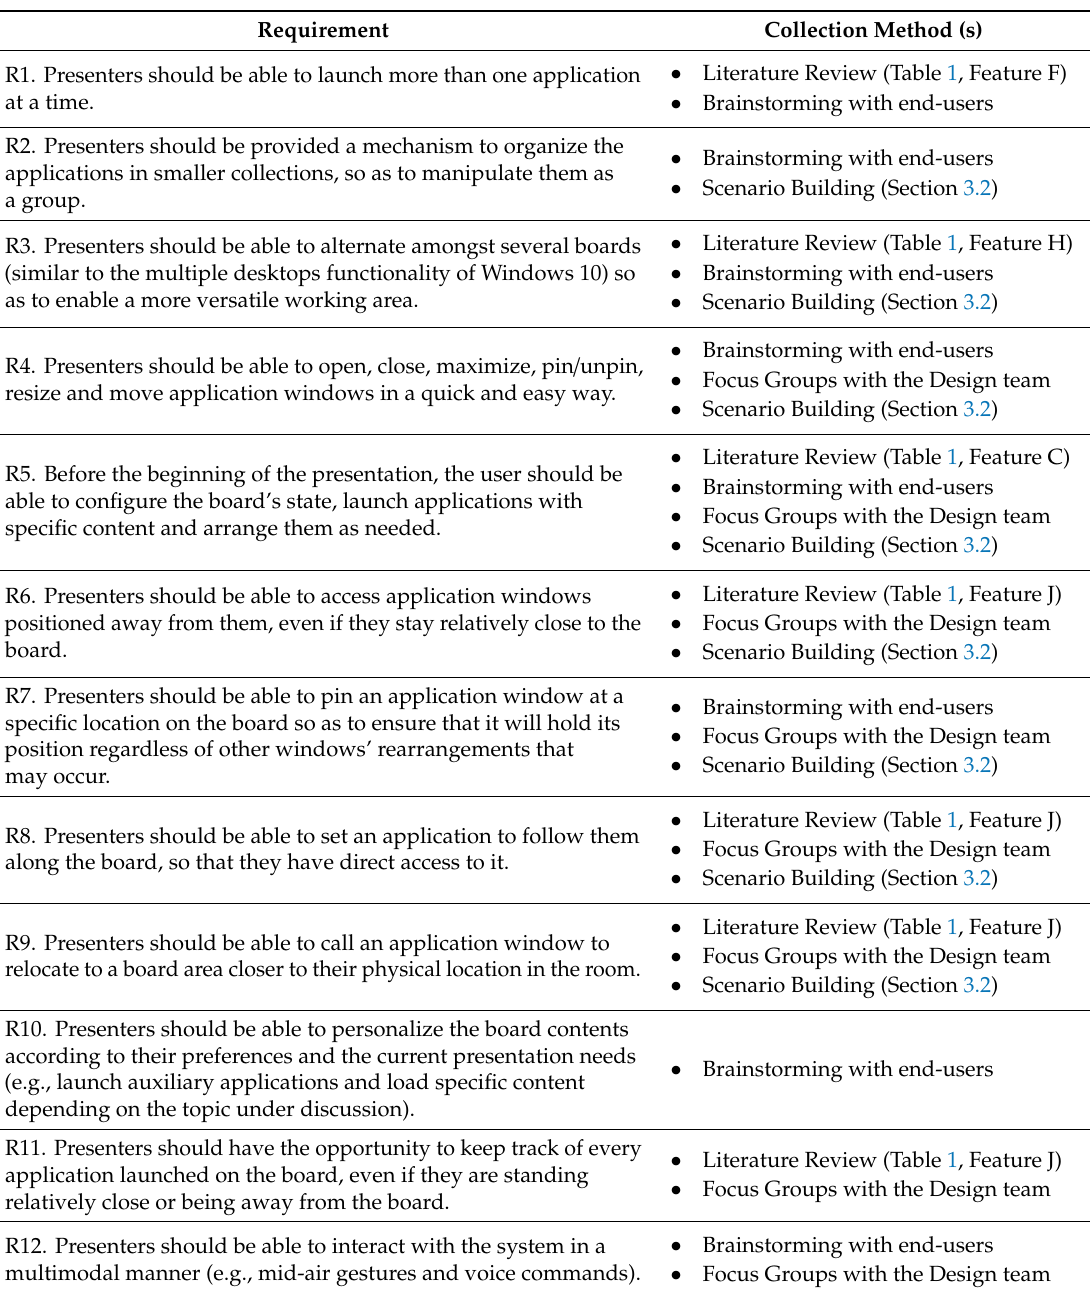
Table 3. High-level requirements of the CognitOS